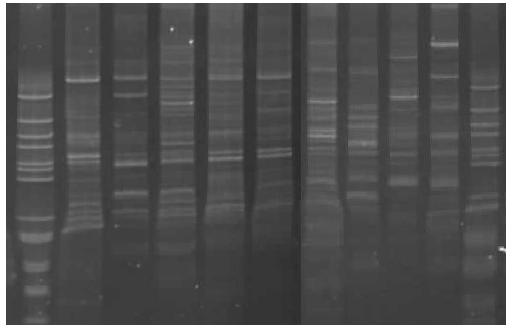
Figure 5. Amplification analysis of the obtained profiles using random amplified polymorphic DNA (RAPD) primer 5 ′ ACCGCGAAGG3 ′ (from left to right—‘Clone 2’, ‘Clone 3’, ‘Clone 5’, ‘Clone 6’, ‘Clone 7’ (Slovak Republic), ‘Pruhonicky 55’, ‘Gerda’, ‘Morena’, ‘Goluboe vreteno’, ‘Bakcharskaya’).